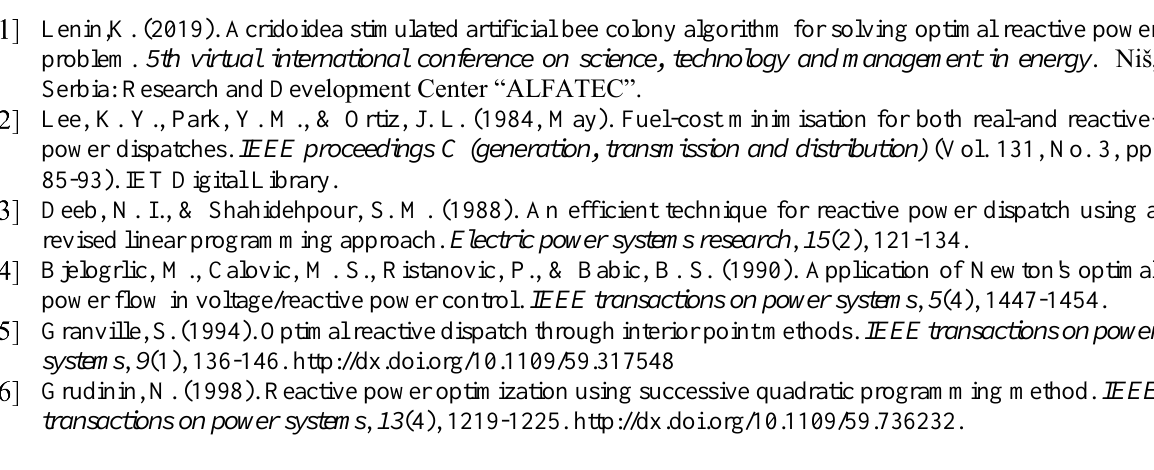
Figure. 2. Comparison of real power loss with respect to percentage of reduction